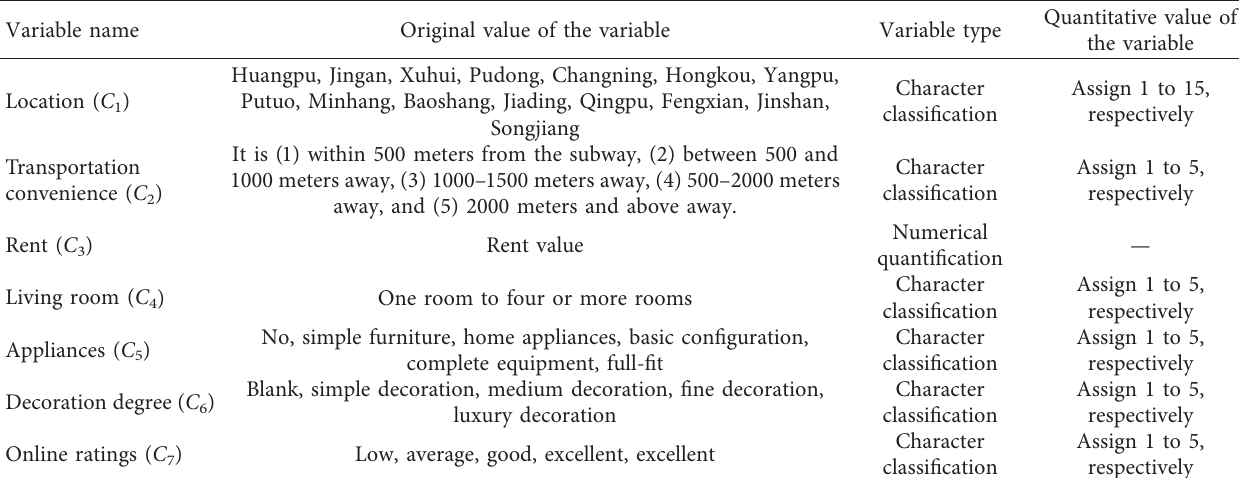
Table 3: Measurement of multiattribute indicators.